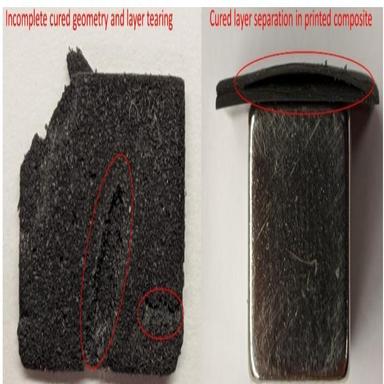
Observed defects in SrFeO composite (left) and NdFeB composite (right) printed using resins containing 25 wt% magnetic fillers.